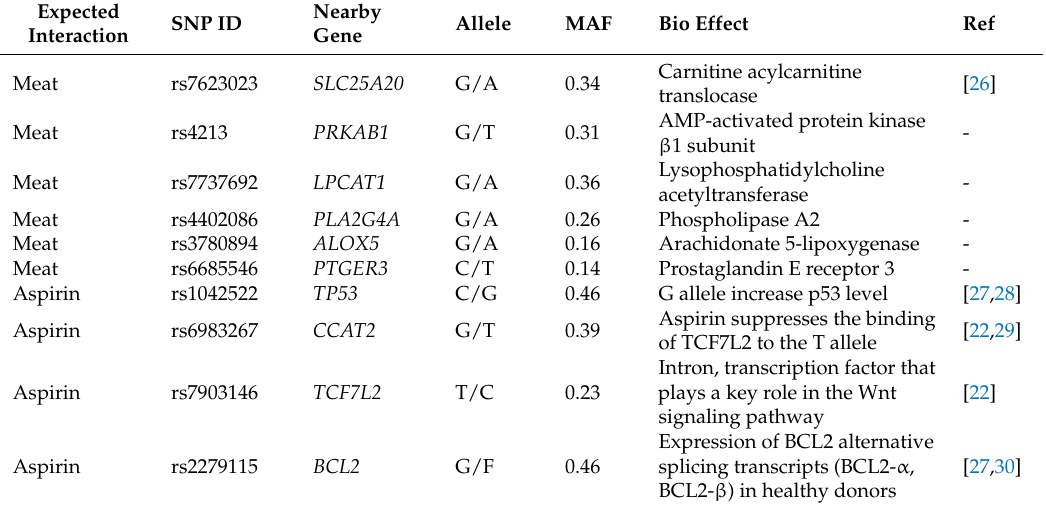
Table 5. Suggested biological effects of the selected